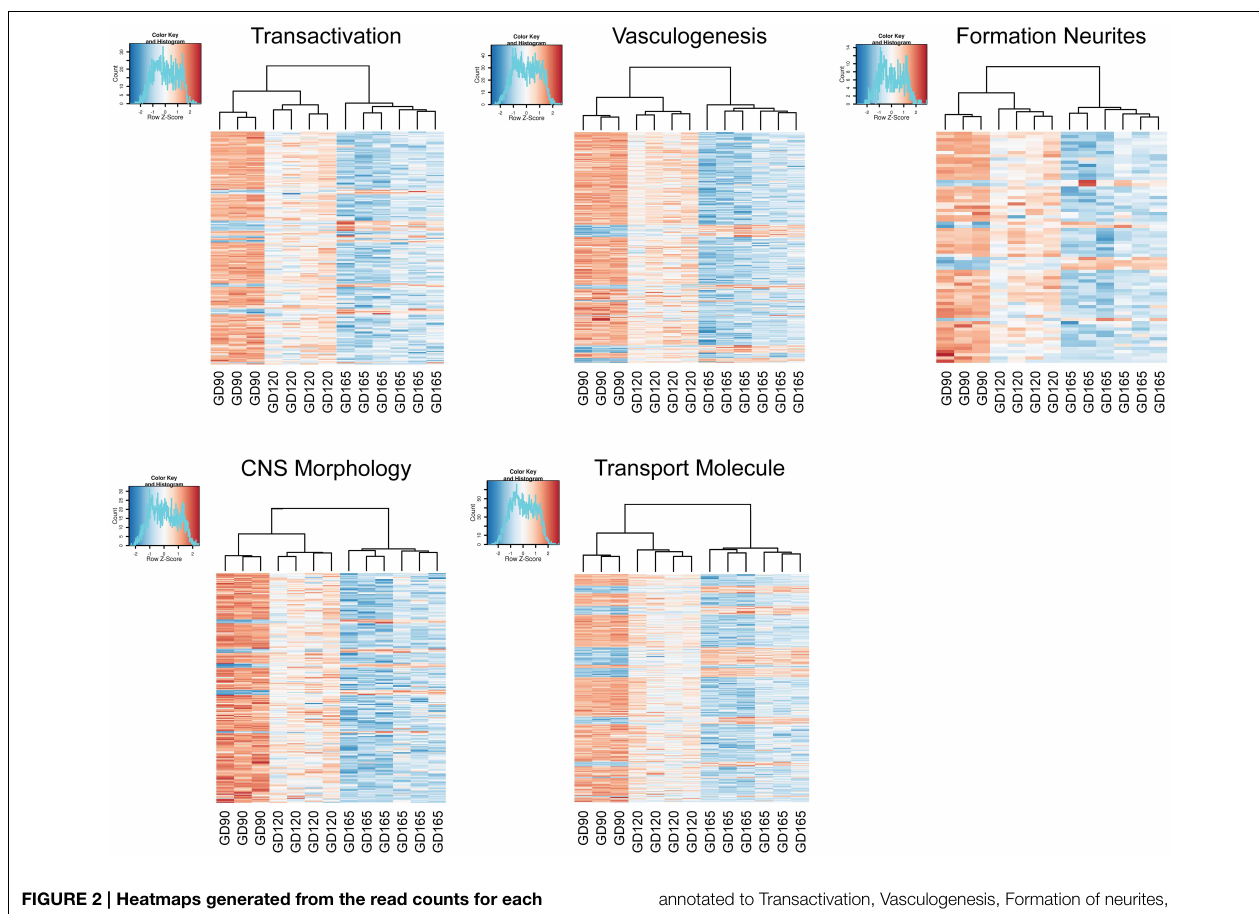
FIGURE 2 | Heatmaps generated from the read counts for each transcript related to certain gene sets for choroid plexuses at gestation day (GD) 90, GD120 and GD165. The gene sets were genes